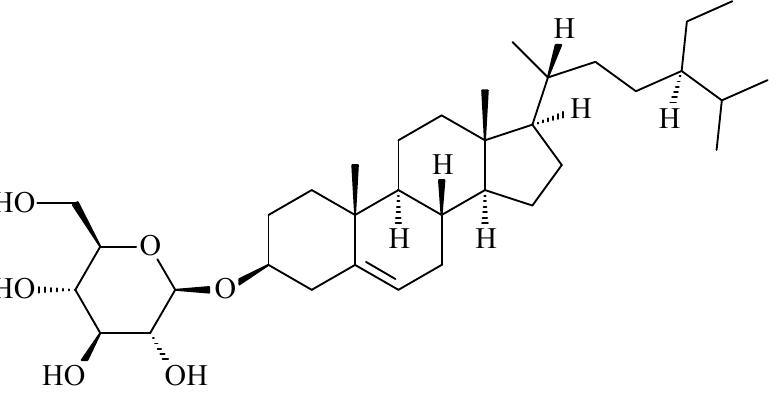
Figure 5. Chemical structure of 3 .